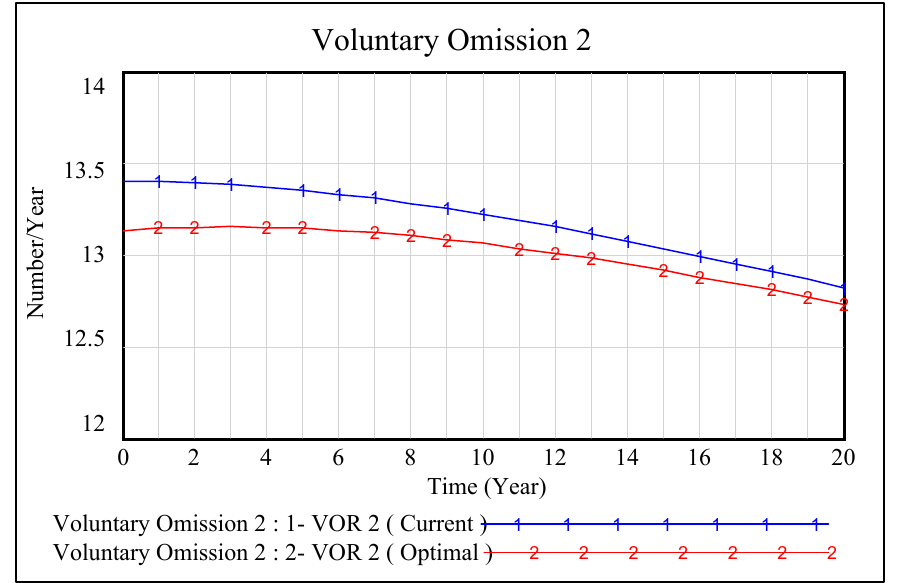
Figure 18. Comparison of the effect of the current and optimal amounts of the voluntary omission rate 2 on the current variable of voluntary omission 2.